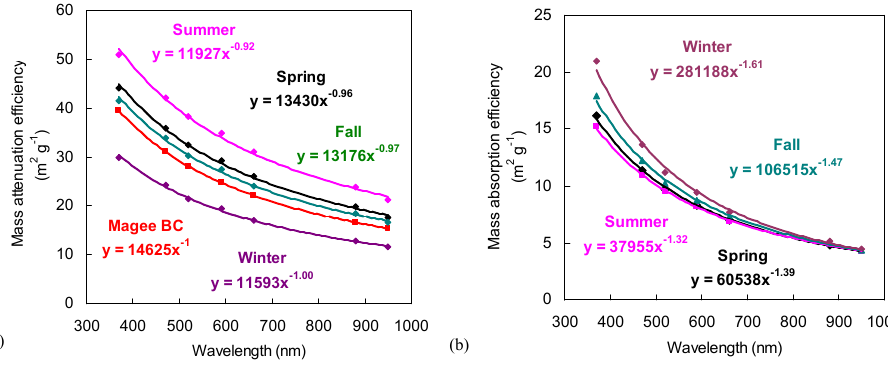
Fig. 5. Seasonal variations of (a) specific attenuation efficiency of aethalometer BC and (b) mass absorption efficiency of EC as a function of wavelength.